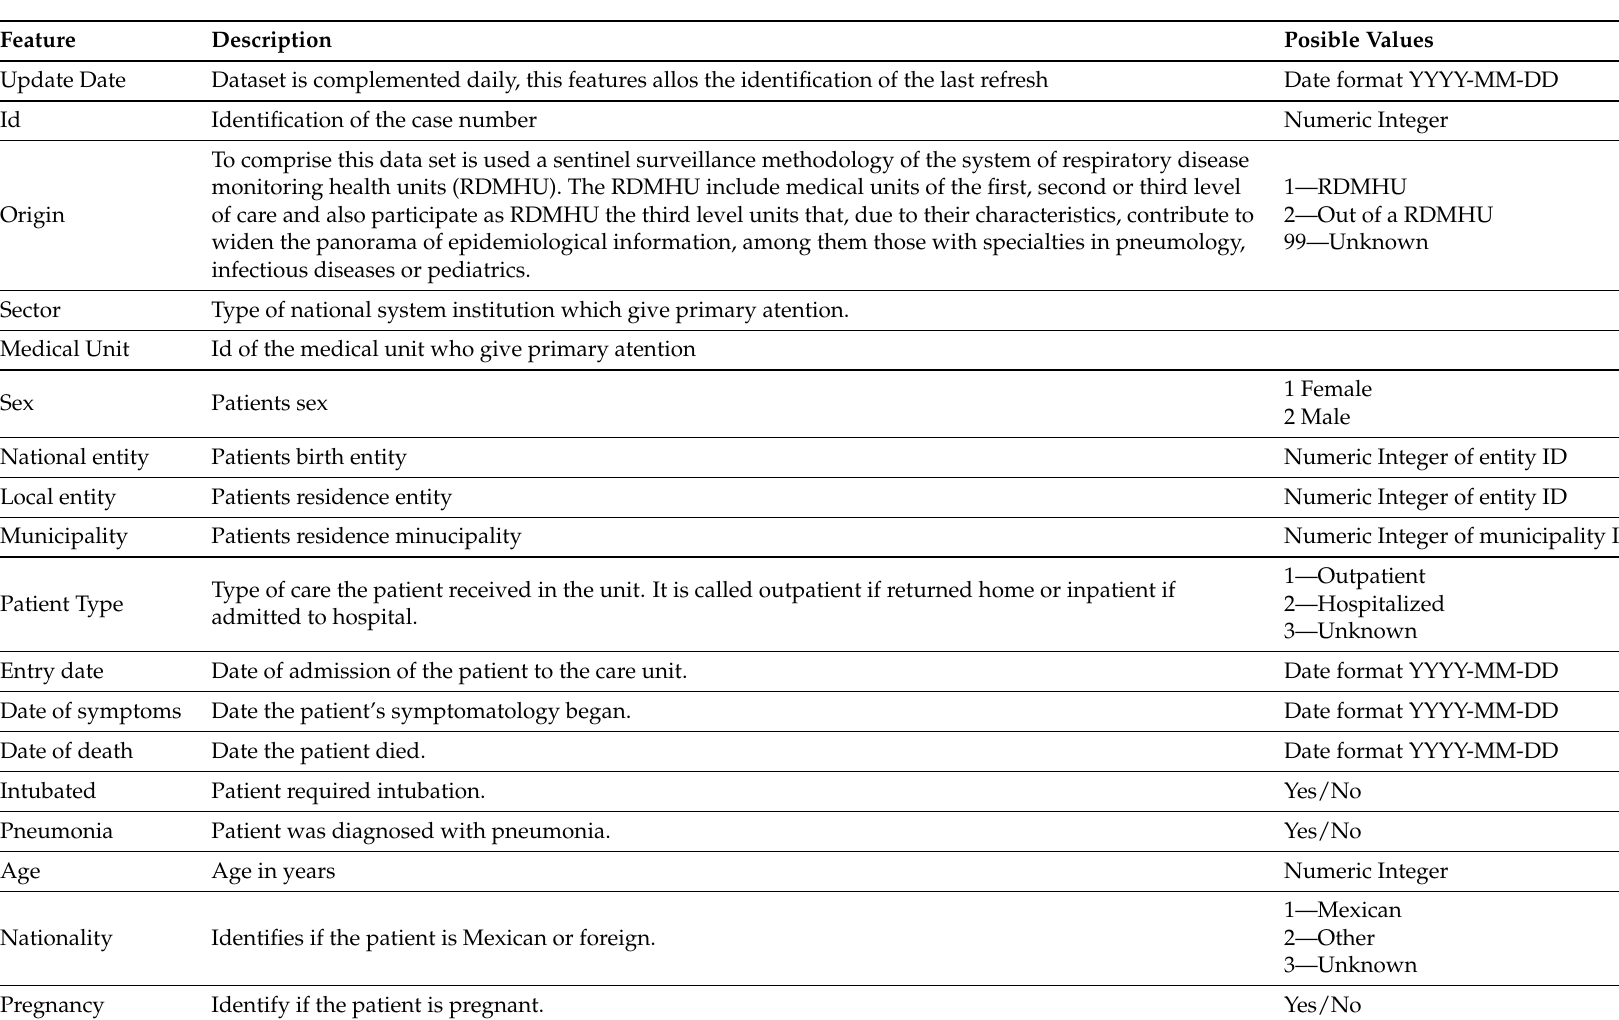
Table 1. Table of the features included in the